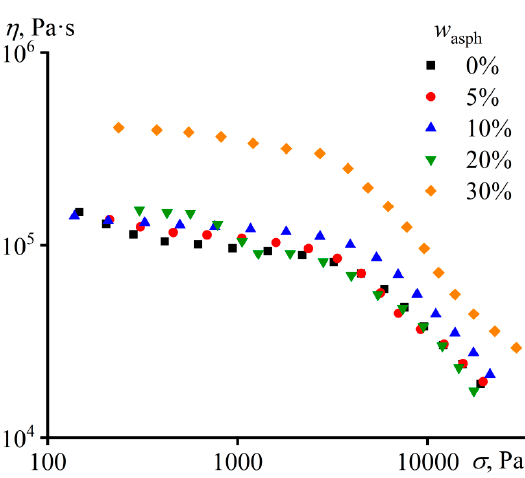
Figure 4. The dependences of viscosity on shear stress for PIB and its mixtures containing a different mass fraction of asphaltenes at 25 °C.